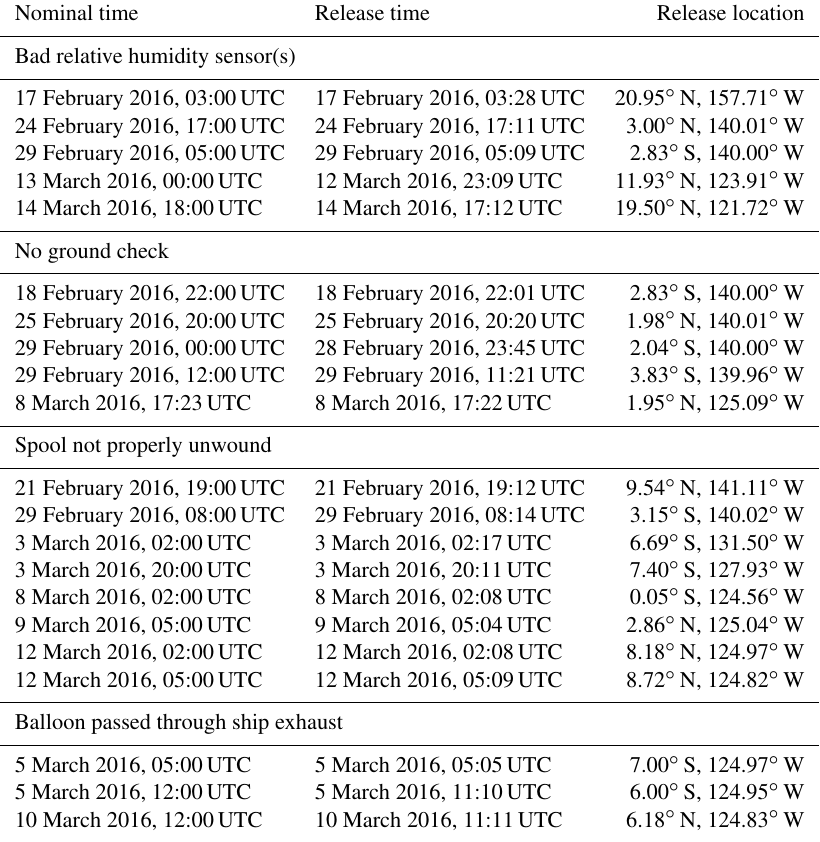
Table 3. ENRR soundings from NOAA Ship Ronald H. Brown with other known